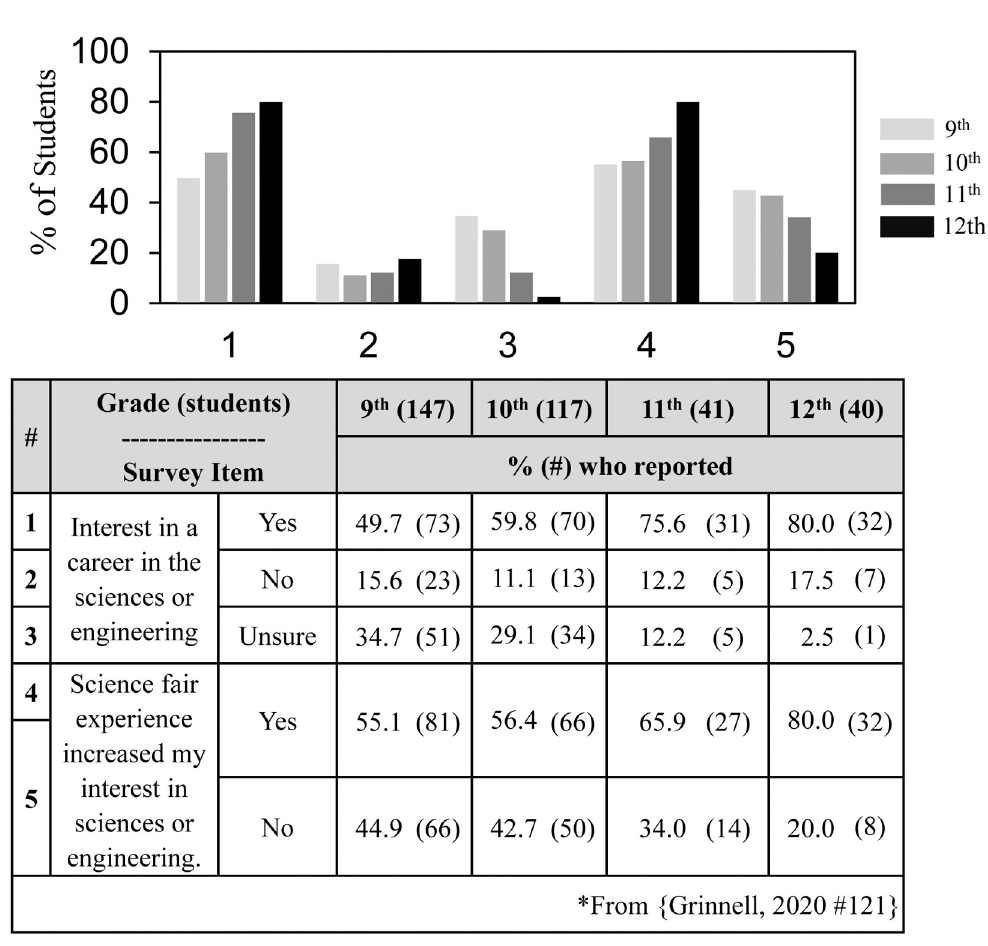
Fig 2. Differences in career interests and impact of science fair depending on grade in which high school students participated in science fair.